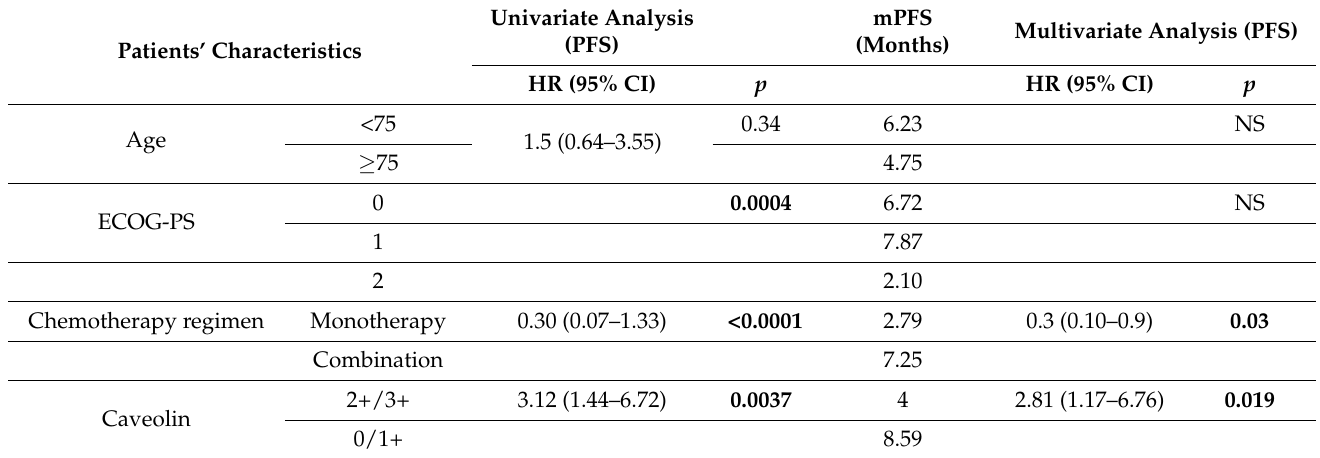
Figure 4. PFS by positive (0 and 1+ vs. 2+ and 3+) Caveolin-1 expression in the whole cohort. median PFS: 4.0 vs. 8.59 months (HR:3.12, 95%CI:1.44–6.72, p = 0.0037). Table 5. Univariate analysis and multivariate analysis for Progression Free